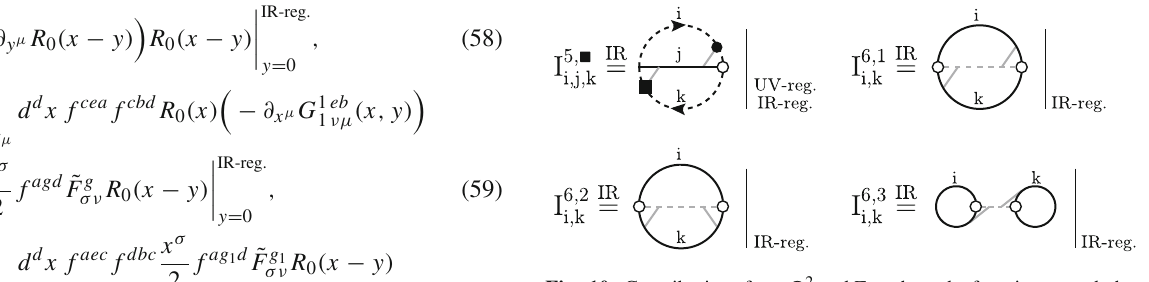
Fig. 10 Contributions from (cid:6) 2 and (cid:5) 4 , where the function q, such that 3 q ( • ) = 0 and q ( × ) = 1, shows the degree of the background field in the corresponding vertex. The symbol ◦ denotes that the corresponding vertex does not contain the integration and it is considered at the zero. The numbers i , j , k mean the type of the propagator, see Fig.